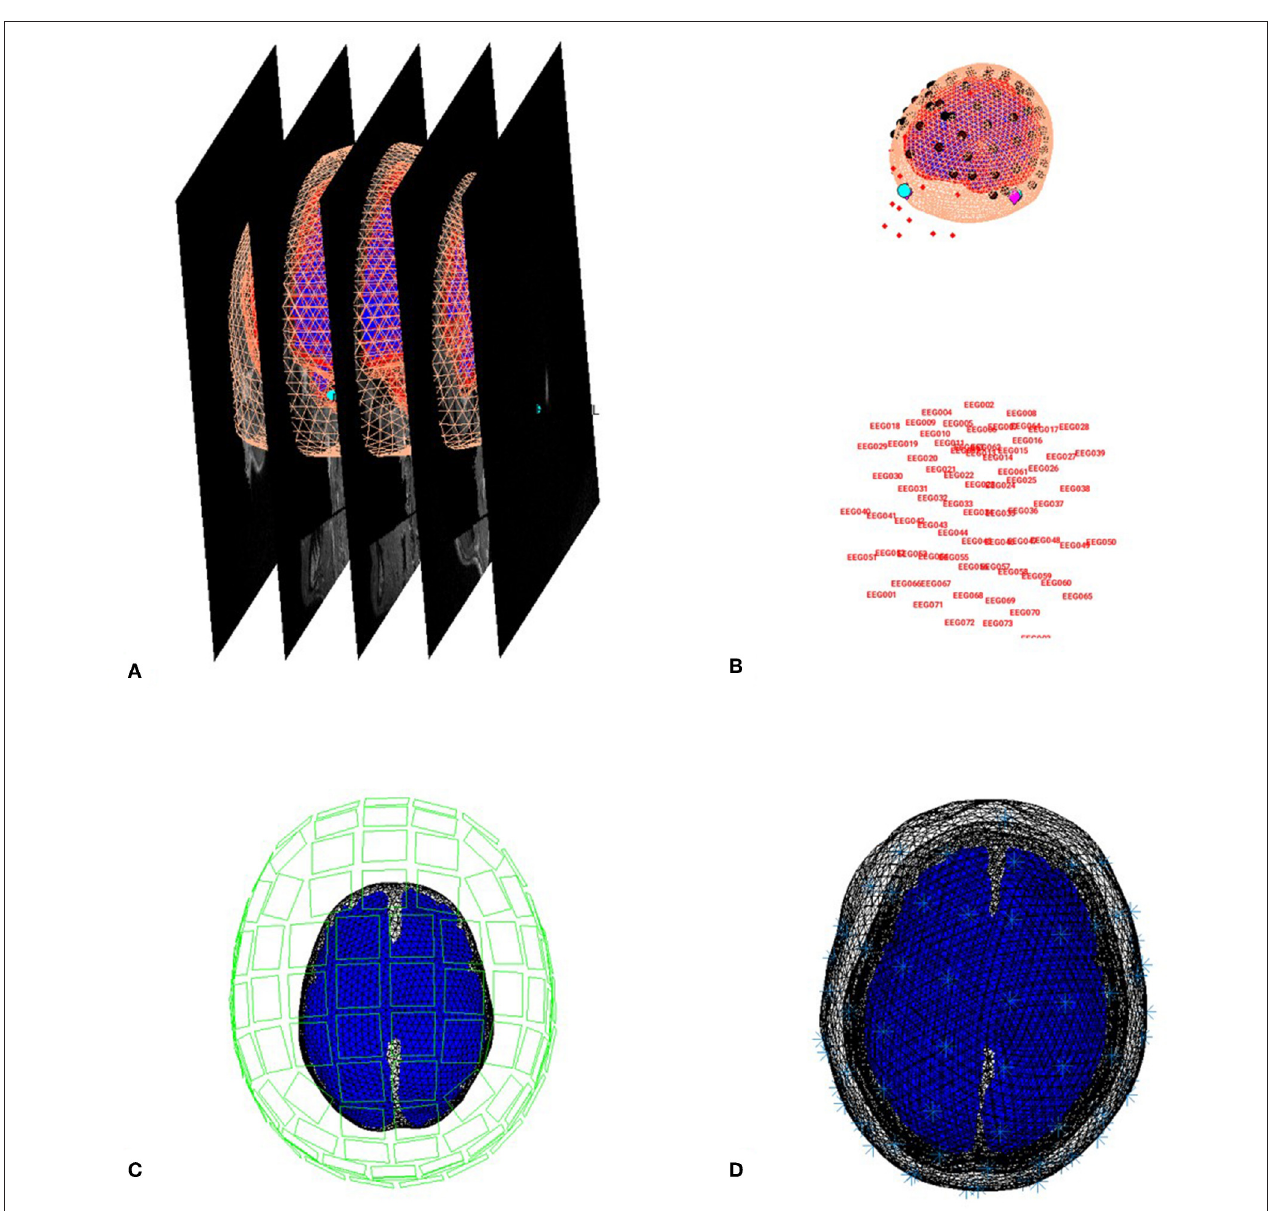
FIGURE 6 | Coregistration of meshes with MRI (A) and meshes with EEG and MEG (B,C) and surfaces used for forward model (D)